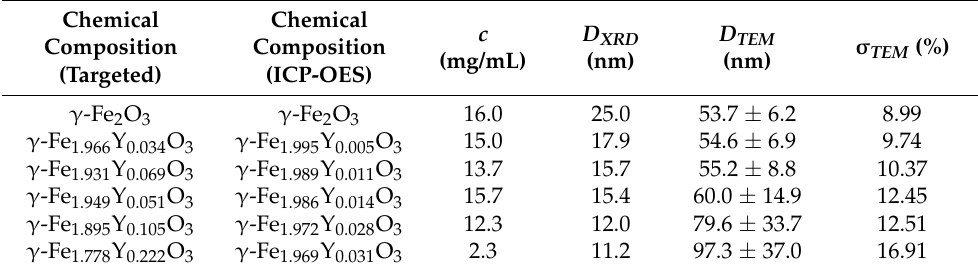
Table 1. Chemical composition of YIONs according stoichiometric ratio of starting compound (targeted) and actual composition determined by ICP-OES. Ferrofluid concentration c , crystallite